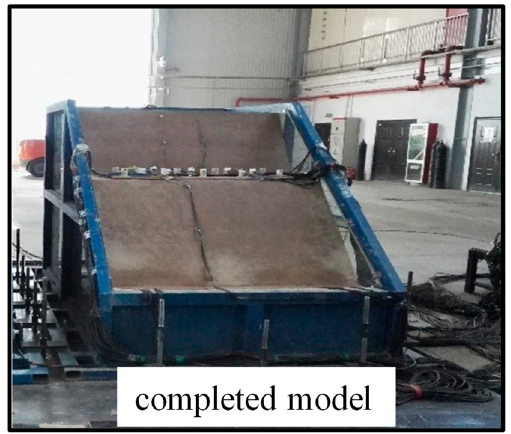
Figure 5. The completed landslide model.